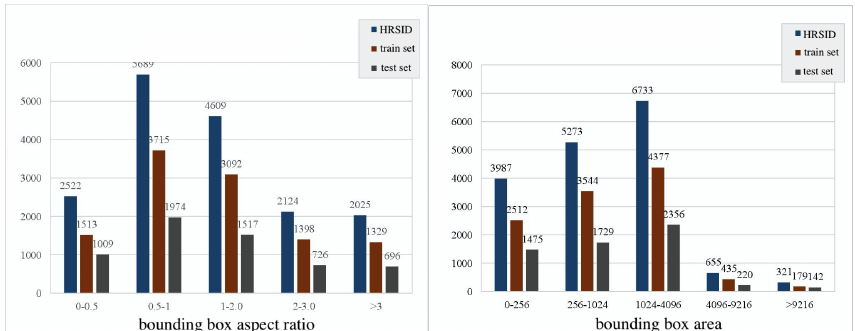
Figure 11. Statistical graph of target aspect ratio and area distribution in HRSID.